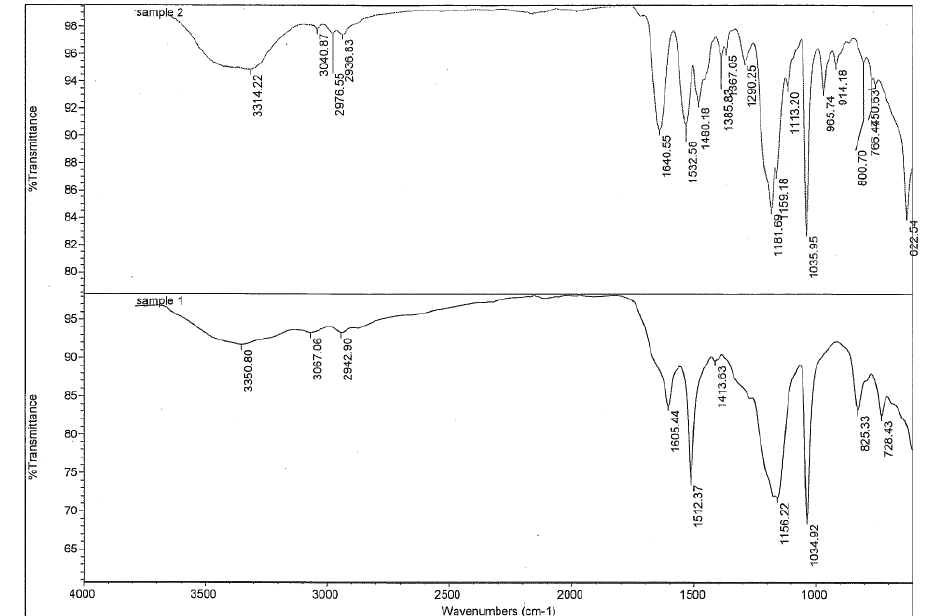
Figure 4. FT-IR spectra for zwitterionic resin (Sample 1) and hydrogel resin (Sample